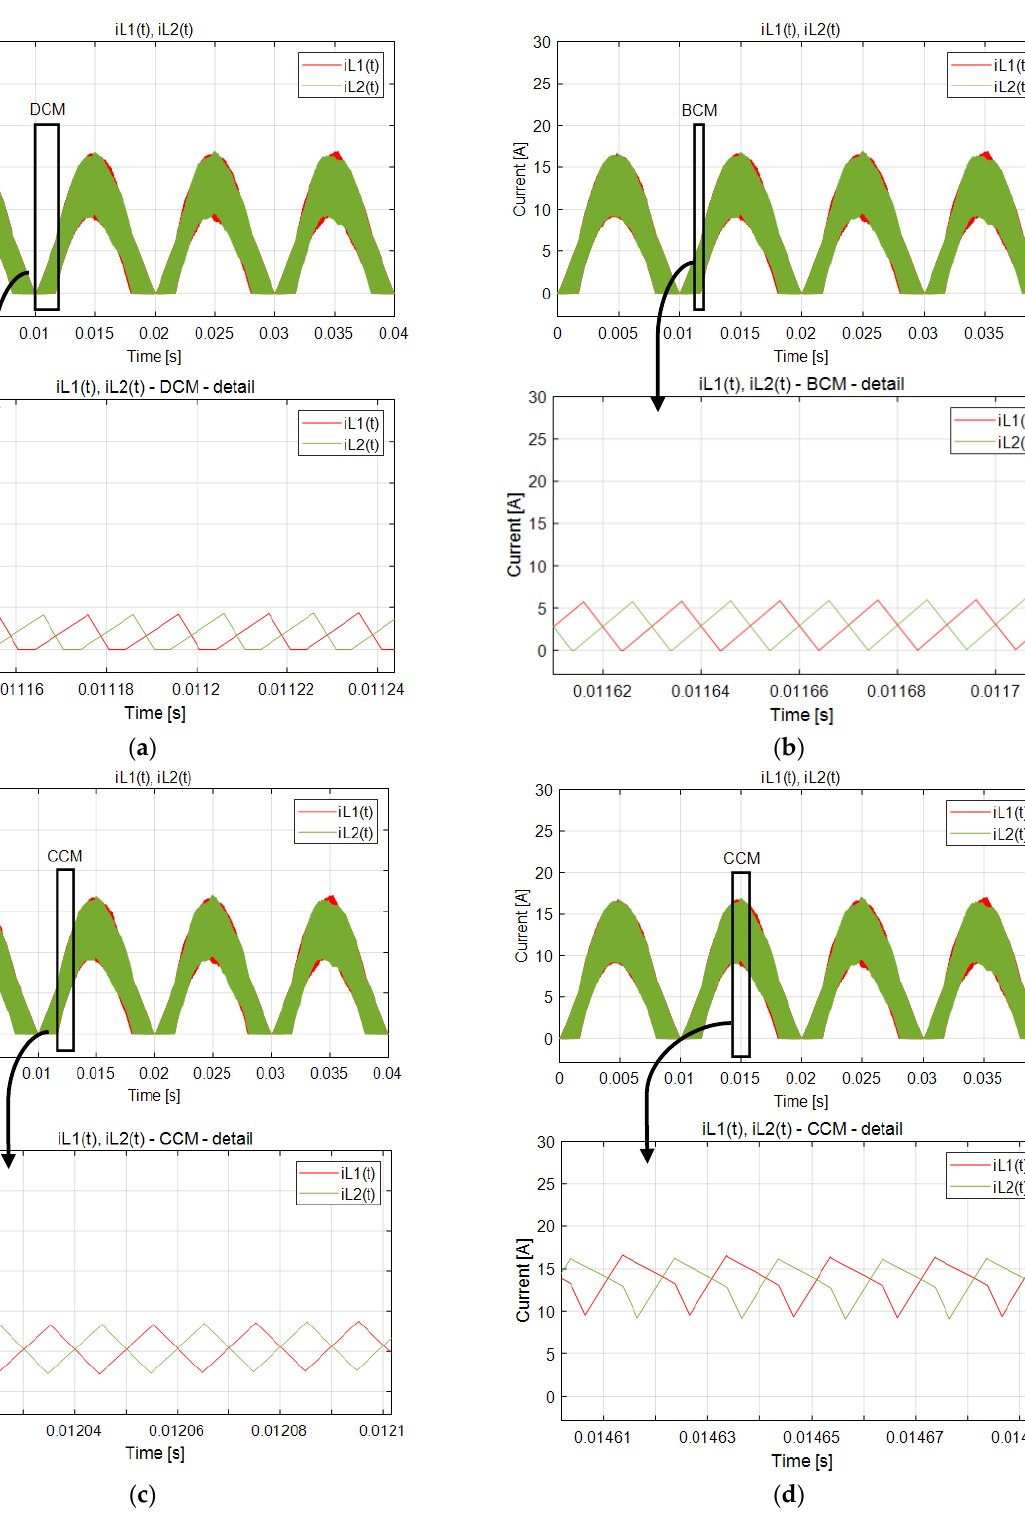
Figure 8. L 1 and L 2 inductor currents’ (I L1 , I L2) ) representation at low and high frequency representa- tions; ( a ) DCM; ( b ) BCM; ( c ) CCM for D > 0.5; ( d ) CCM for D < 0.5.